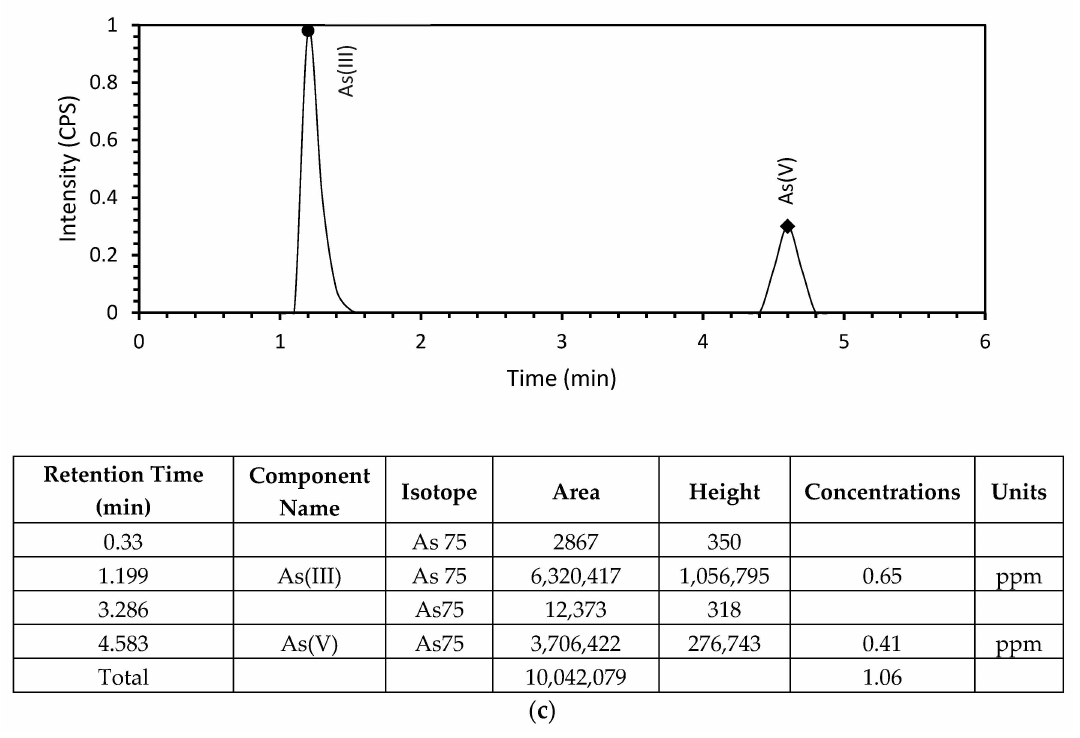
Figure 7. Arsenic speciation for ( a ) untreated sample, ( b ) treated sample with UV and (BC/nTiO 2 ) US , ( c ) treated sample with UV and (BC/nTiO 2 ) P